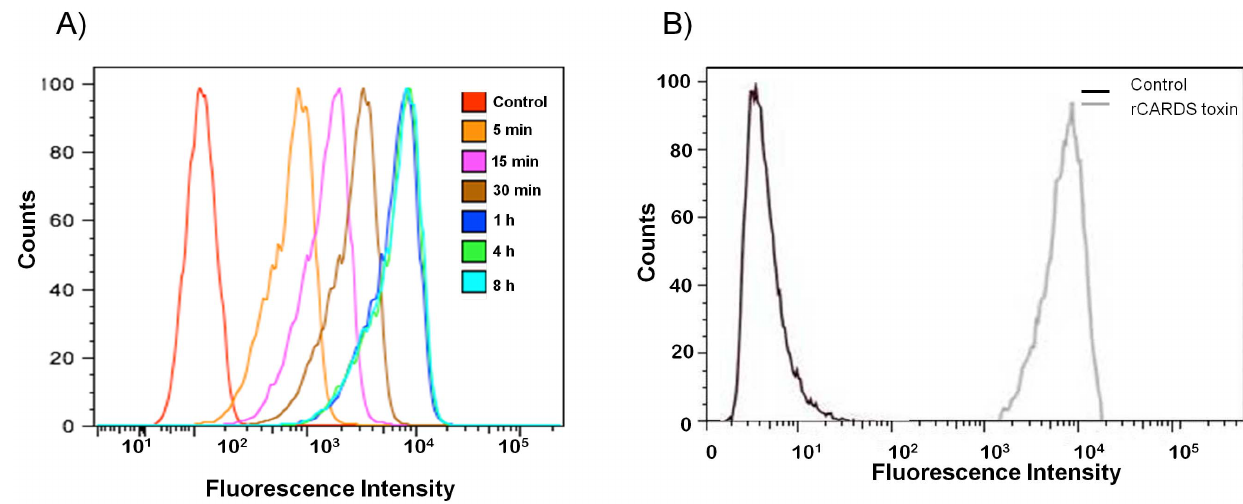
Figure 3. FACS analysis of rCARDS toxin association with HeLa cells. A) HeLa cells were treated with 10 m g/ml of pacific blue-A fluorescence dye-coupled toxin (PBA-CARDS) at different time intervals (5 min to 8 h) at 4 u C, washed and quantified by FACS. Cells treated with carrier solution served as controls. B) HeLa cells were treated with 10 m g/ml of rCARDS toxin for 30 min at 4 u C, washed and incubated with rabbit polyclonal anti- CARDS toxin antibodies (1:1000) and counterstained with goat anti-rabbit IgG-conjugated with Alexa Fluor 488 (1:500) followed by FACS. The control shows HeLa cells with no toxin treatment but stained with primary and secondary antibodies.